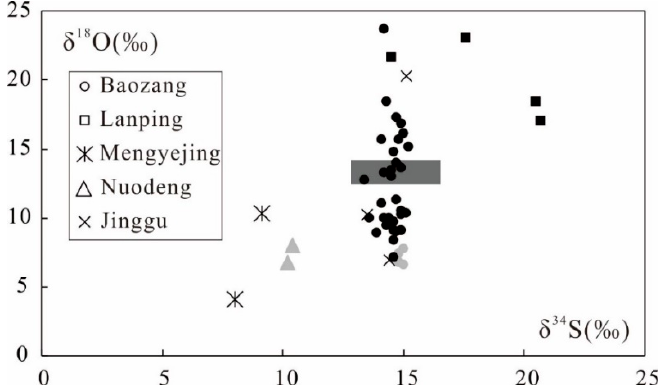
Figure 9. S-O isotopic compositions of evaporites in the Lanping–Simao Basin. The shaded box represents S-O isotopic compositions of marine gypsums of the Late Cretaceous period [19]. The dark black symbols indicate layered gypsum samples, whereas grey symbols indicate veined gypsum samples.